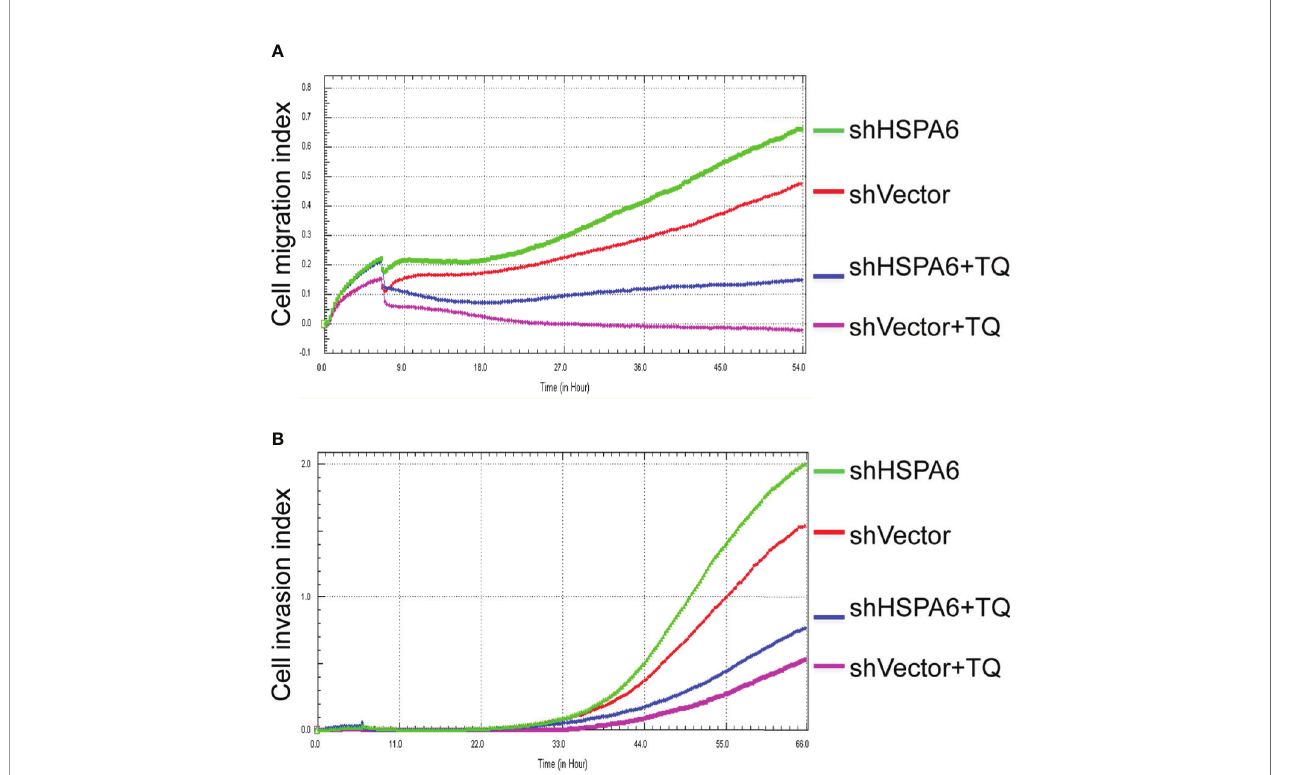
FIGURE 5 | TQ attenuates the inhibitory effect of cell migration and invasion for HSPA6 when knocking down of HSPA6. (A) Cell migration. (B) Cell invasion. The ef fi ciency for knocking down of HSPA6 was shown in Figure 3A . “ shHSPA6 ” indicates knocking down of HSPA6 for clone 531, and “ shVector ” indicates the empty vector as a control without knocking